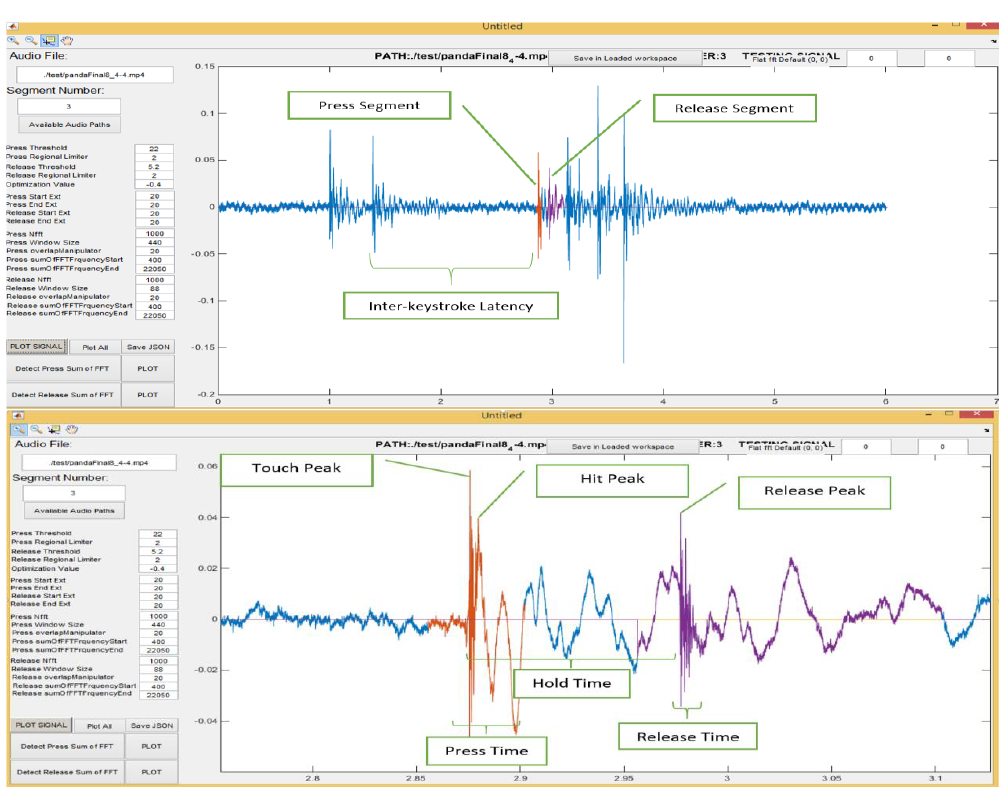
Figure 7. Various features analyzed in this